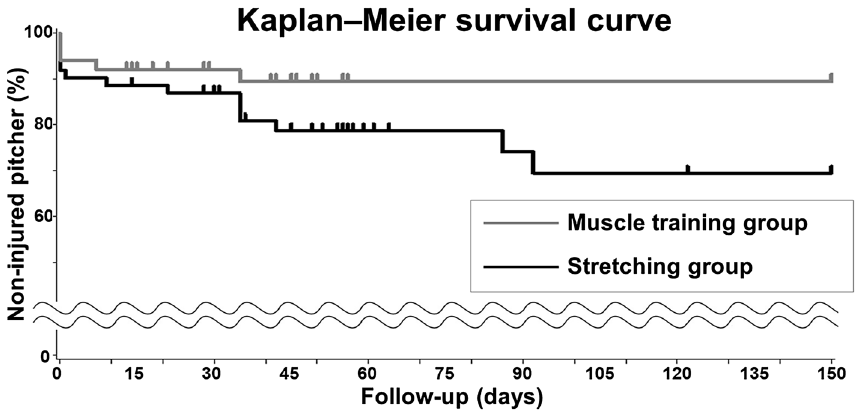
Figure 3. Kaplan–Meier survival curves. The median injury-free times were 52.5 and 49.0 days in the stretching and muscle-training groups, respectively. A log-rank test revealed no significant differences in the injury rates between the stretching and muscle-training groups ( P = 0.175).